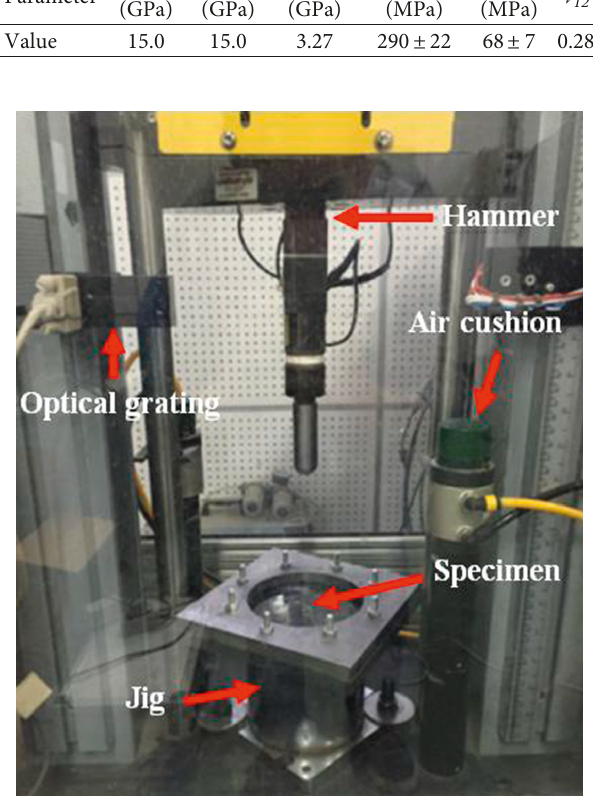
Figure 1: INSTON 9520HV testing machine.